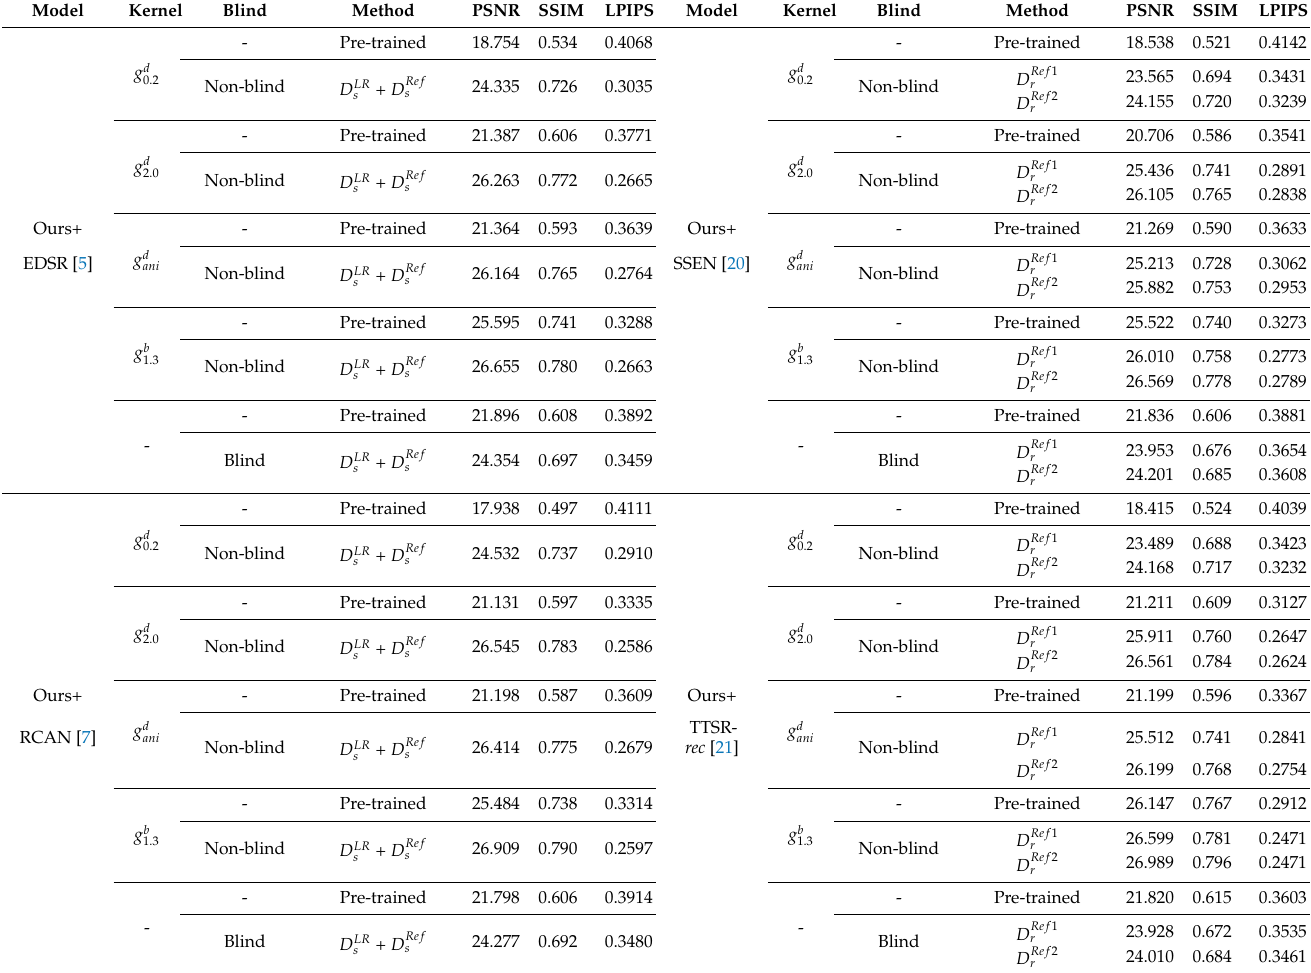
Table 5. Online learning results with non-bicubic